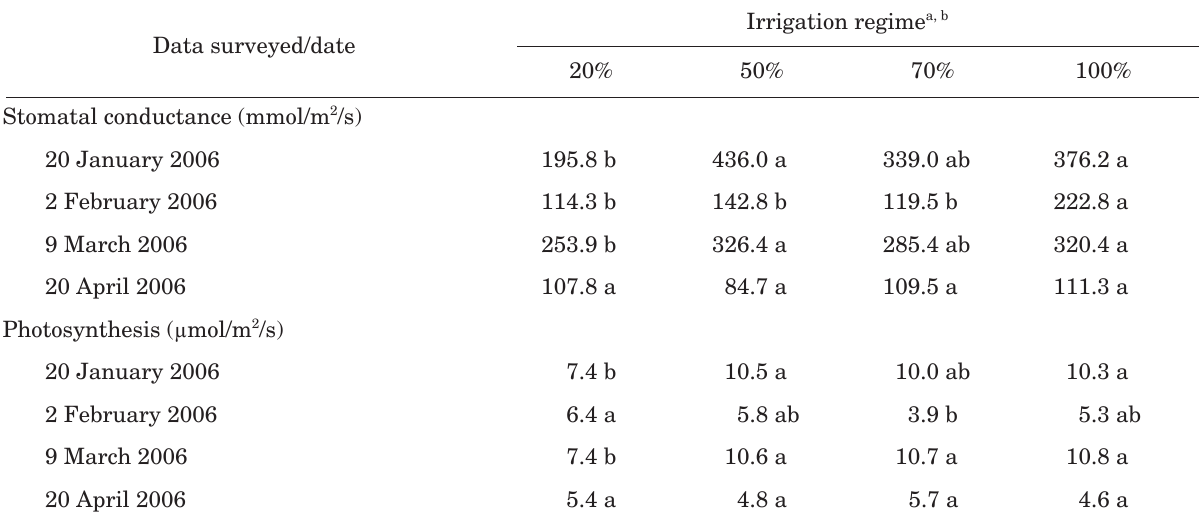
Table 2. Mean stomatal conductance and photosynthetic rate of potted grapevines subjected to 20, 50, 70% or optimal (100%) irrigation regimes as measured on 20 January, 2 February, 9 March and 20 April 2006.